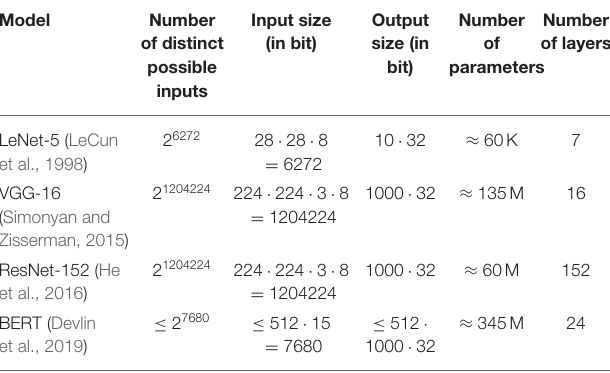
TABLE 1 | The size of the input and state spaces of commonly used architectures in the field of object recognition (LeNet-5, VGG-16, ResNet-152) and natural language processing (BERT) is extremely